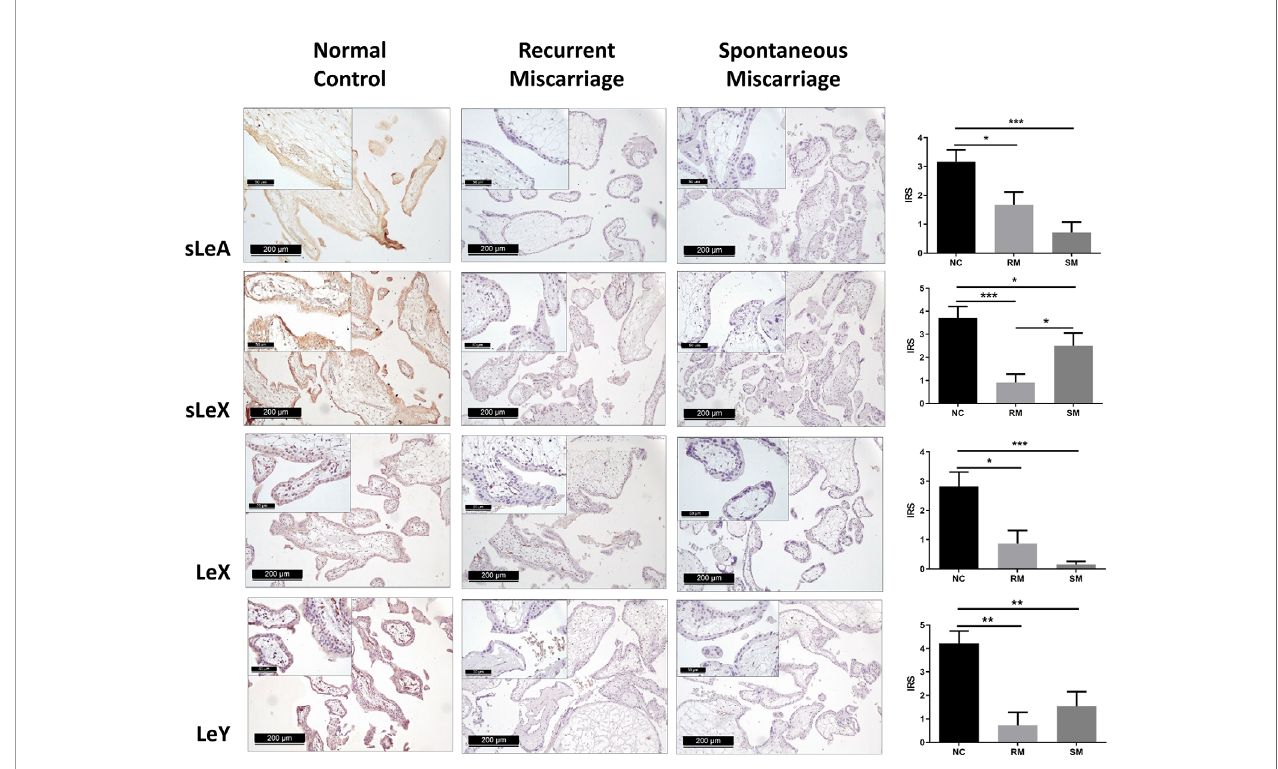
FIGURE 3 | Immunohistochemical staining of four carbohydrate Lewis antigens in the syncytiotrophoblast of three groups of placenta tissues. *P < 0.05, **P < 0.01, ***P <